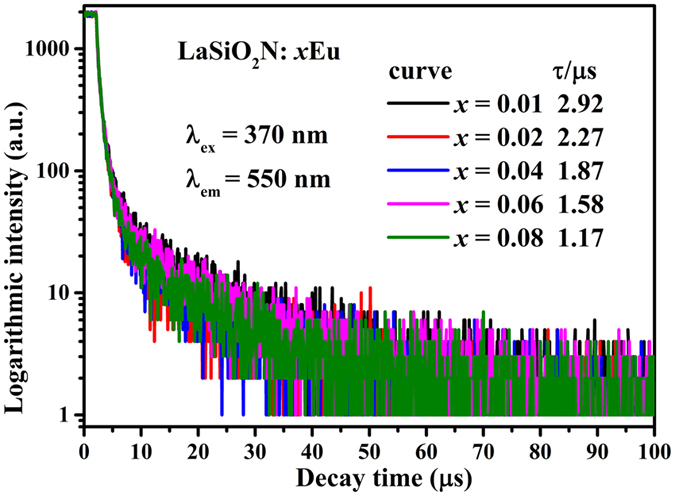
The decay curves of LaSiO2N:xEu (x = 0.01, 0.02, 0.04, 0.06, 0.08).